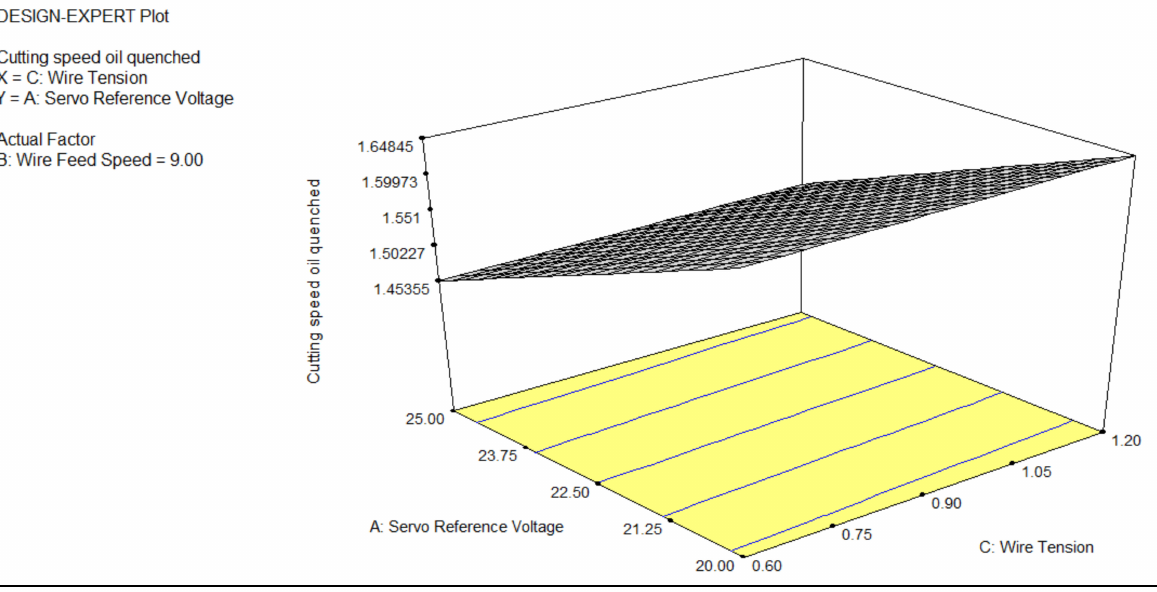
Figure 7. A 3D plot of the effect of the wire tension and servo reference voltage on the cutting